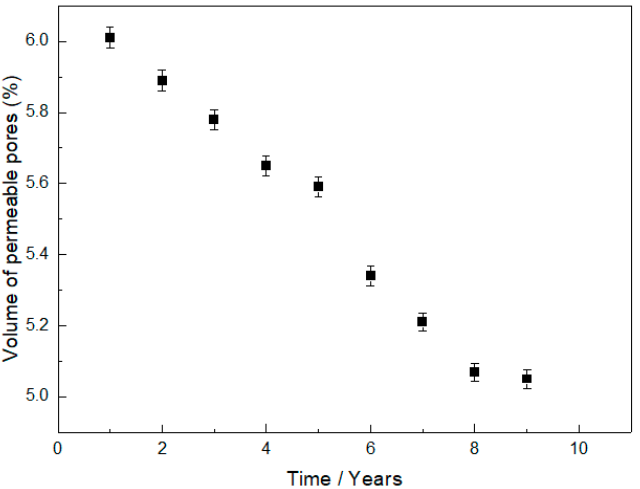
Figure 7. Variation of permeability in concrete with alkaline activation.